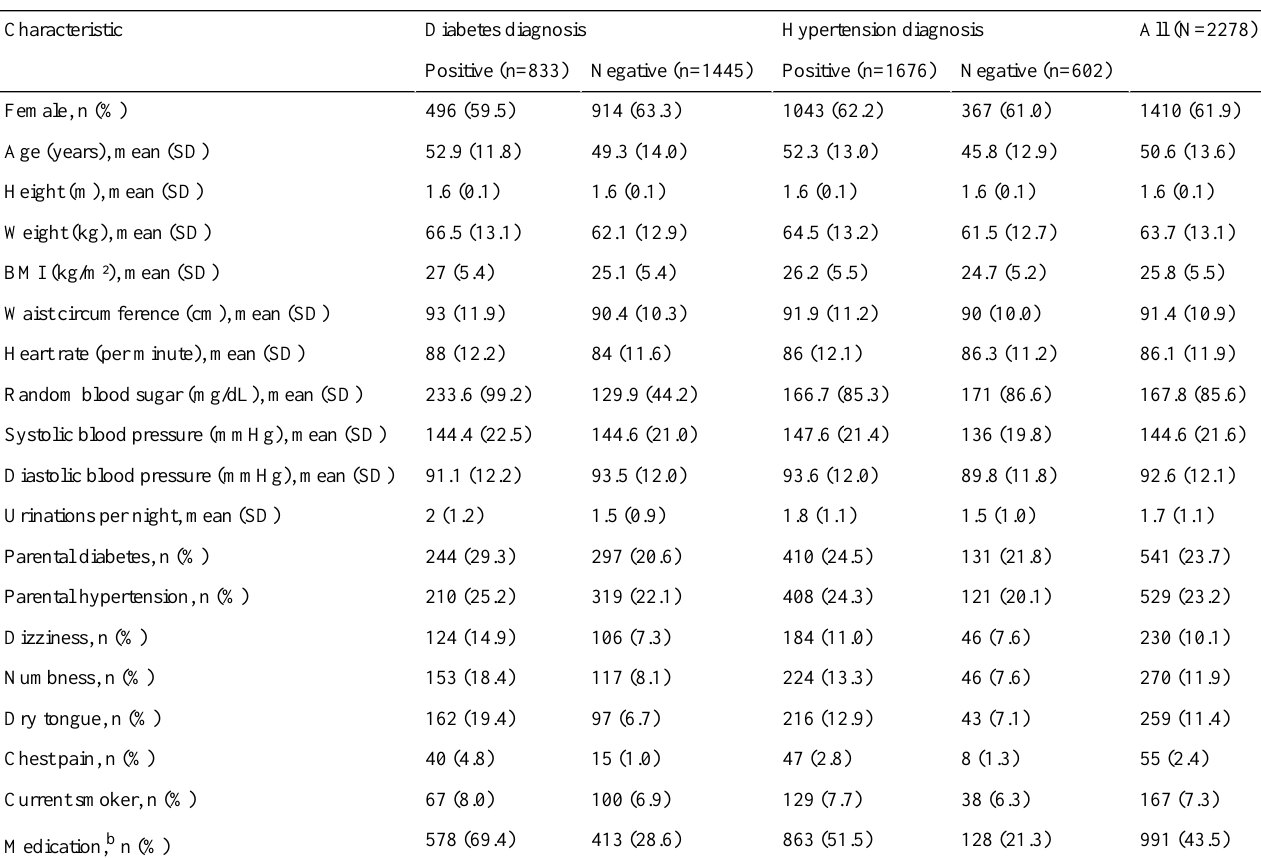
Table 1. Summary of individual screening data (N=2278). a